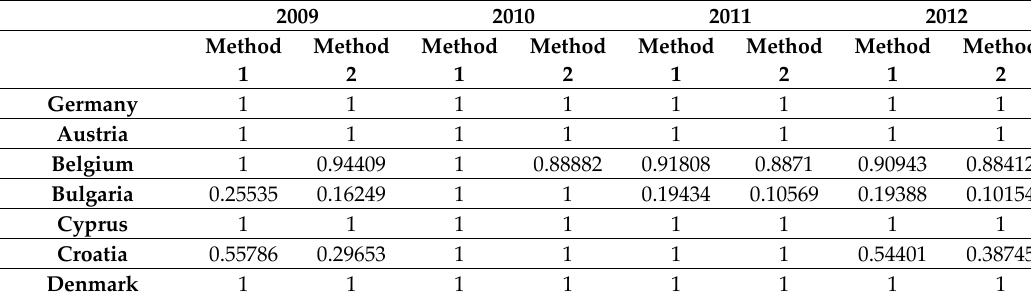
Table 8. Comparison of environmental efficiencies with Method 1 and with Method 2 for the 28 countries in the 2009–2012 period. Source: self